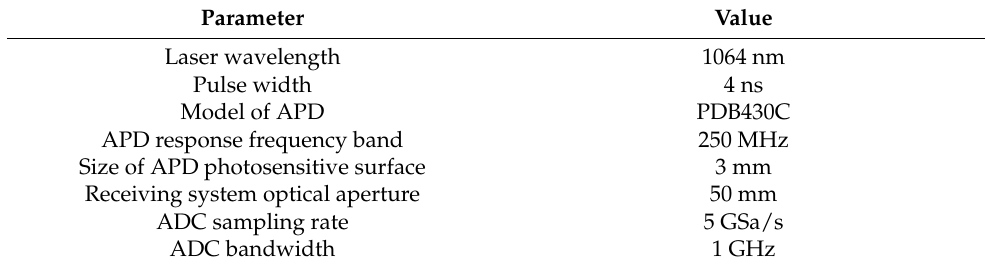
Figure 5. Experimental equipment diagram of the pulse Lidar ranging system.